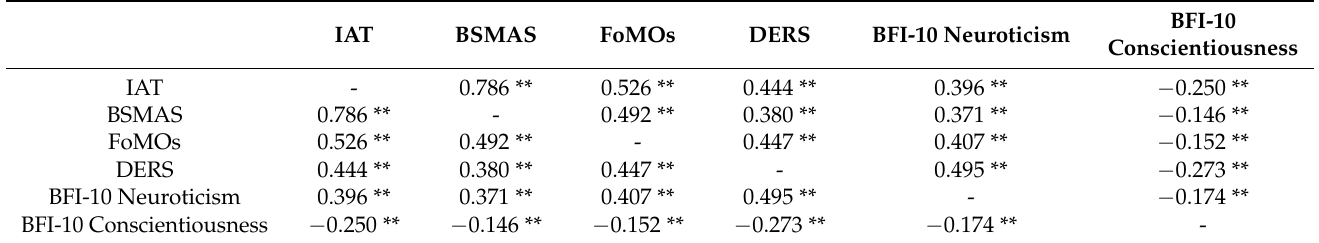
Table 2. Correlation coefficients (Pearson’s r ) between the IAT, BSMAS, FoMOs, DERS, and BFI-10 Neuroticism and Conscientiousness ( n = 397) scores.